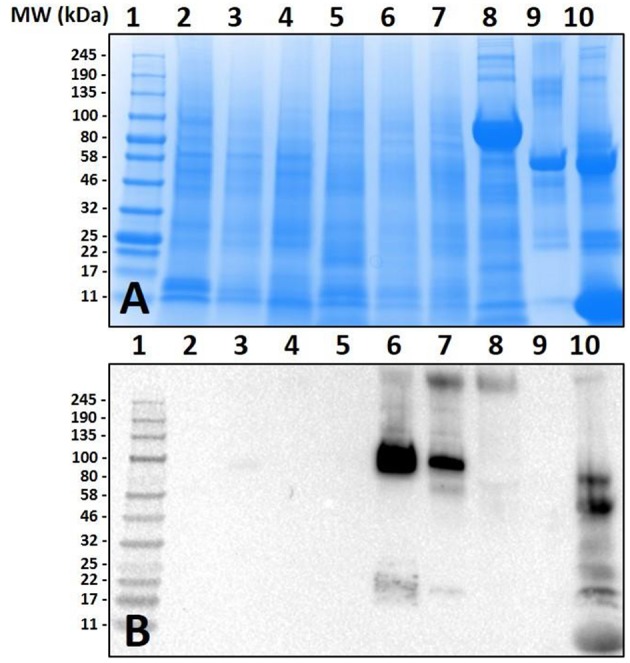
Screening of proteins from Amblyomma americanum for α-gal. Unfed and partially-fed gut tissue and salivary gland tissue homogenates and saliva were run using (A) 7.5% SDS-PAGE, (B) western blot using anti-gal IgM antibody. Lane 1, broad range (11–245 kDa) pre-stained protein standard; Lane 2, Am. americanum unfed midgut tissue; Lane 3, Am. americanum 3D partially-fed midguts; Lane 4, Am. americanum 11D partially-fed midguts; Lane 5, Am. americanum unfed salivary glands; Lane 6, Am. Americanum 3D partially-fed salivary glands; Lane 7, Am. americanum 11D partially-fed salivary glands; Lane 8, Am. americanum 8D saliva (pilocarpine induced); Lane 9, Bovine serum albumin; and, Lane 10, Diluted sheep blood.